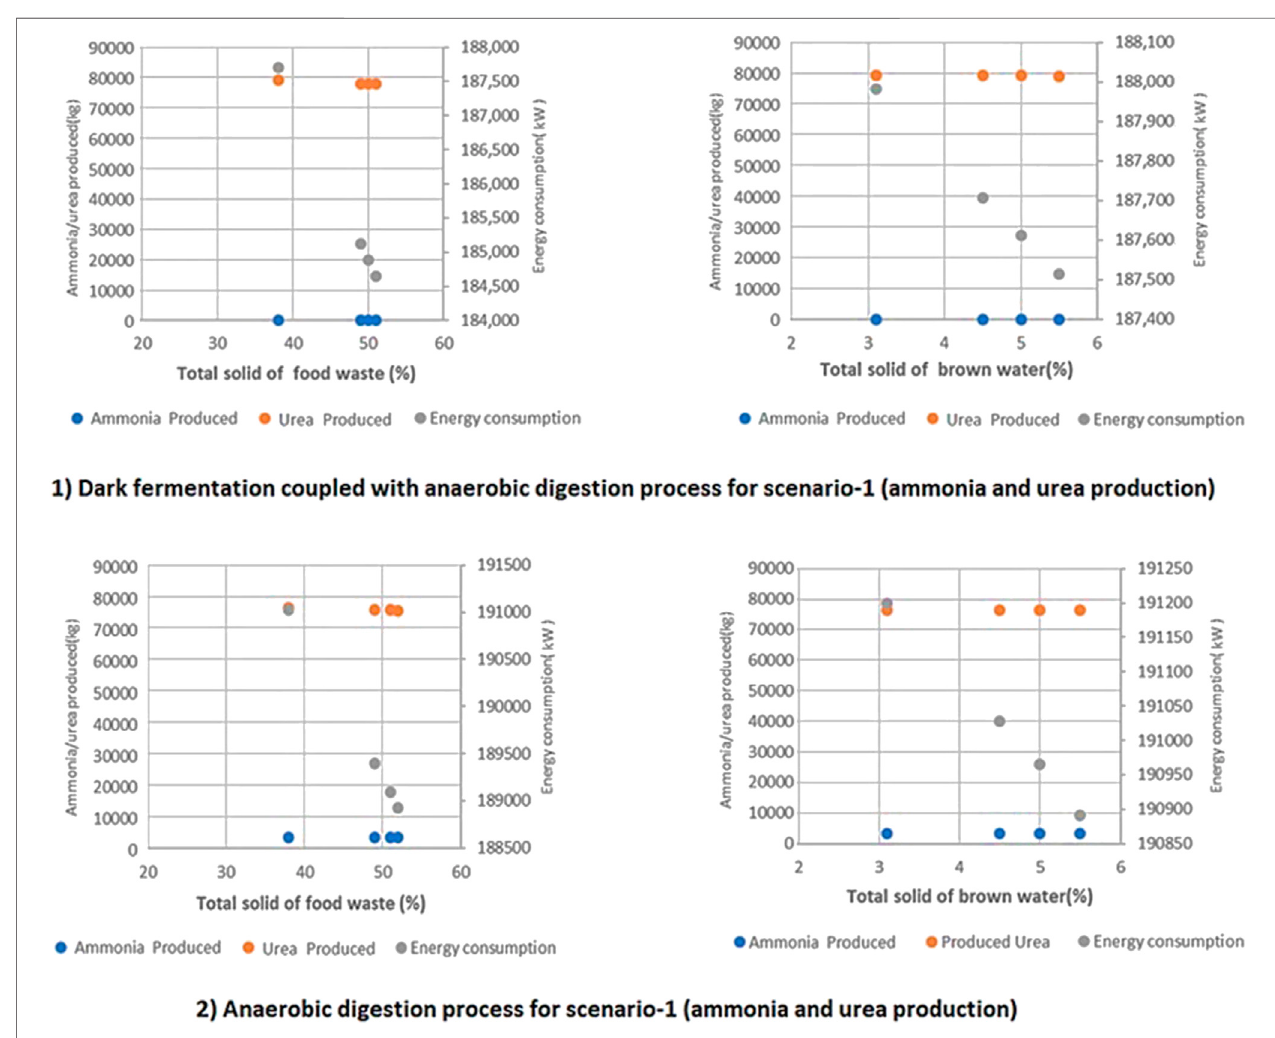
FIGURE 10 | A comparison of the two proposed technologies for ammonia production in terms of energy consumption, ammonia, and urea produced at different TS of FW and BW in a 20 tpd facility for 1) two stage DF coupled with AD 2) AD-only process.